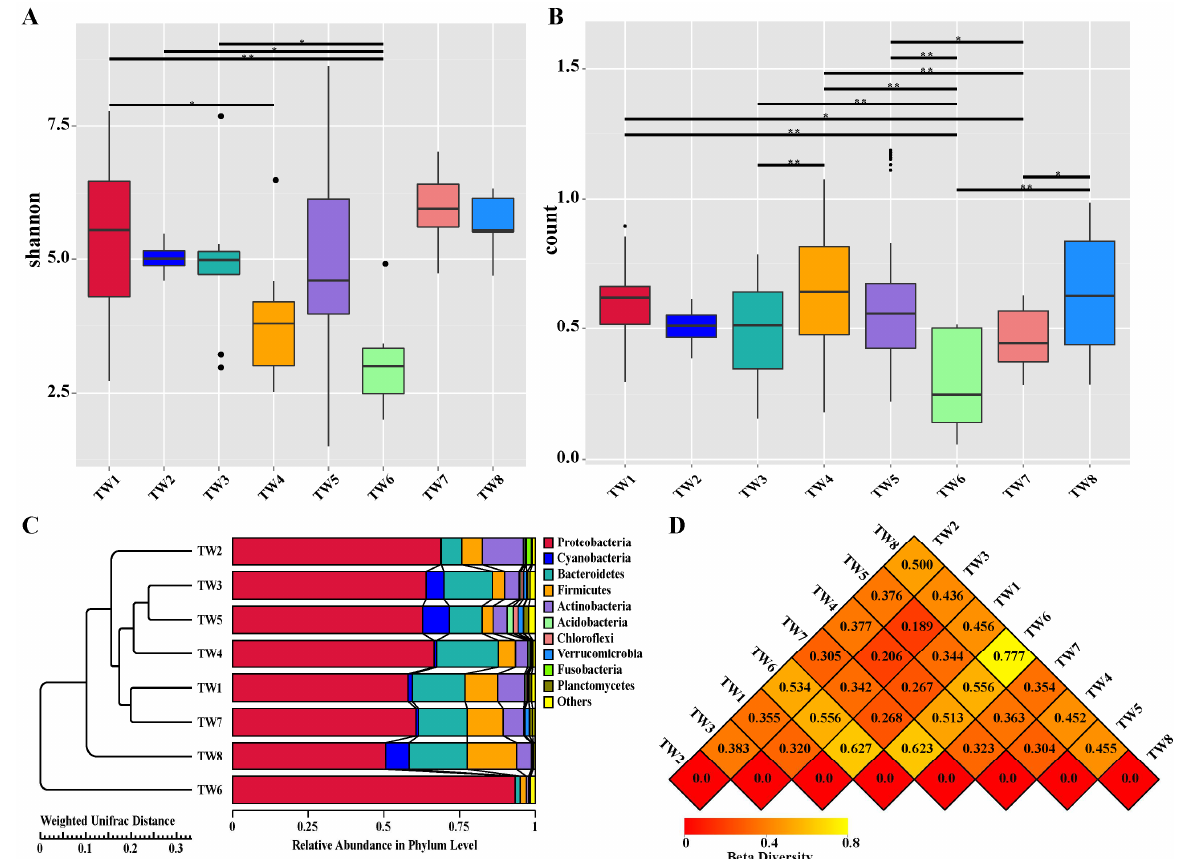
Figure 3. Alpha diversity and beta diversity. ( A ) Analysis of alpha diversity based on the Wilcoxon rank sum test of Shannon index; ( B ) Box plot of differences between beta diversity groups based on unweighted unifrac beta-Wilcox index; ( C ) Beta diversity analysis of UPGMA cluster tree based on unweighted unifrac distance; ( D ) Heat map of distance matrix drawn with weighted unifrac distance. (The smaller the coefficient value, the smaller the difference in diversity between two samples.) * ( p < 0.05) and ** ( p < 0.01).